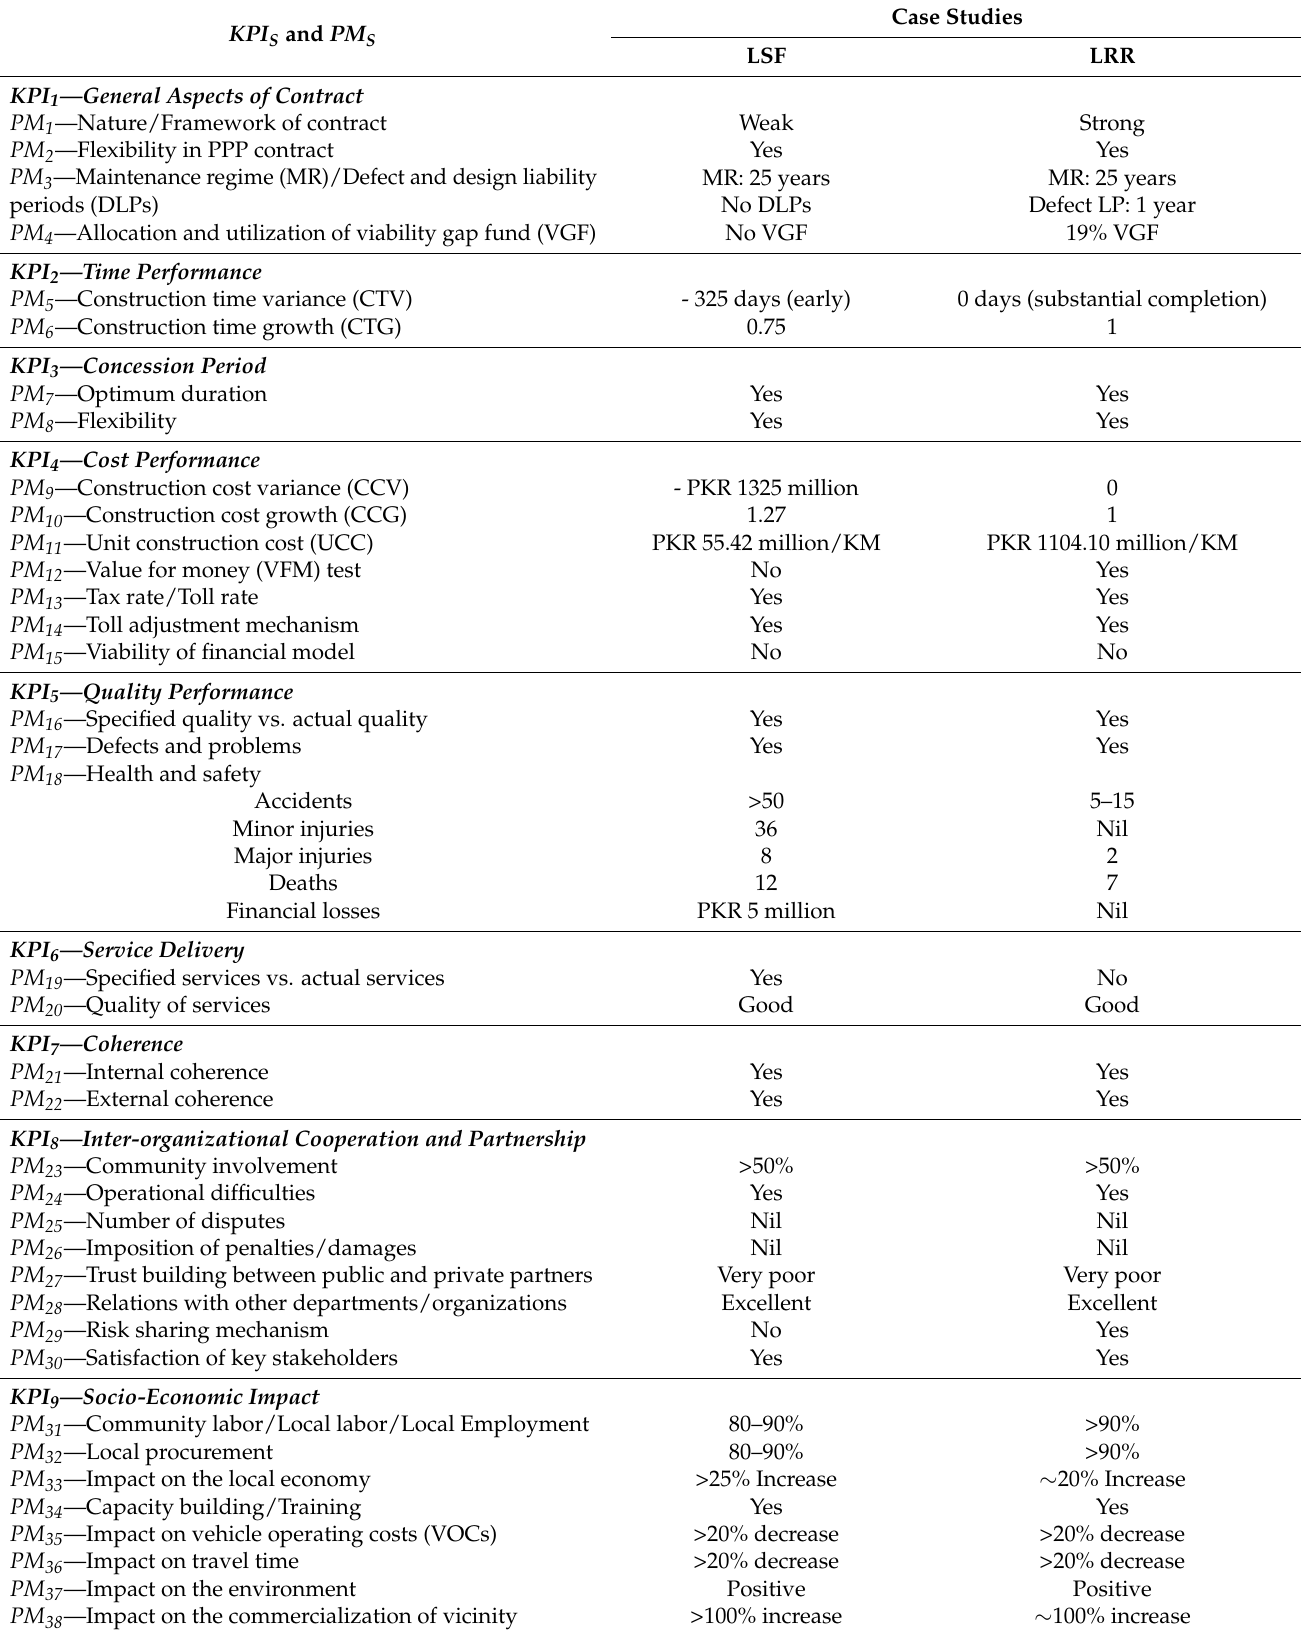
Table 2. Evaluation Results for LSF and